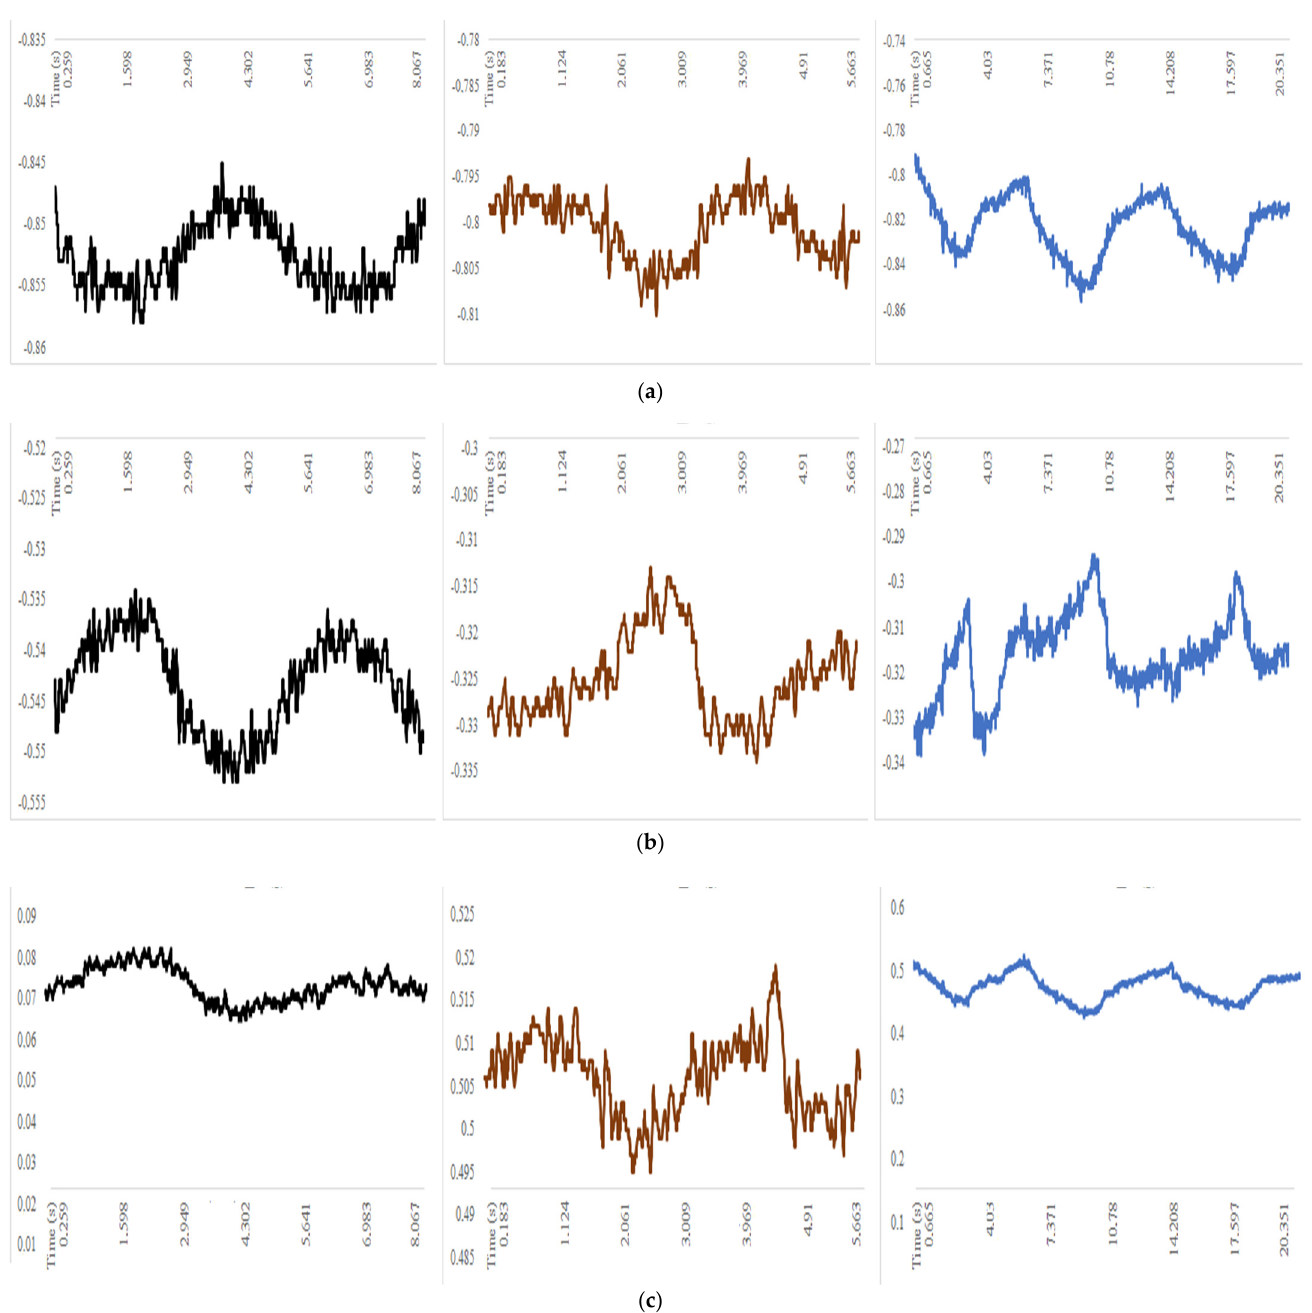
Table 1. A summary of numerical data from the test results in Figures 6 and 7. The boldness indi- cates the parameters. Pre-Operation